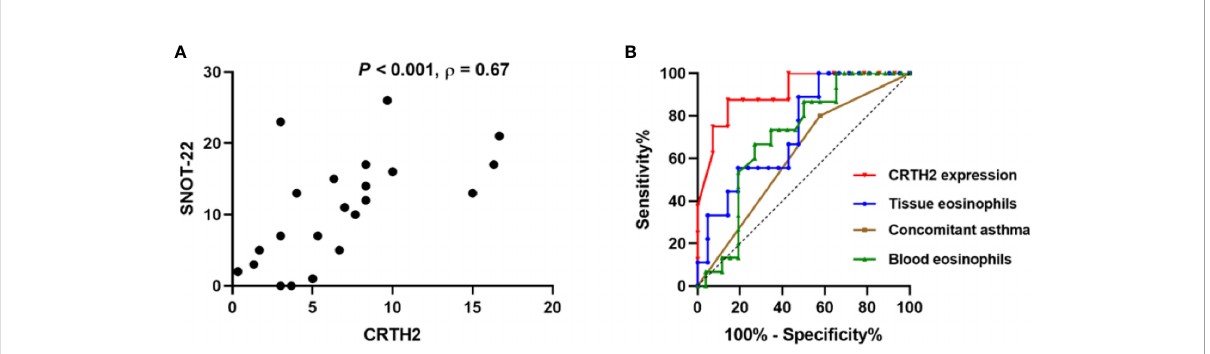
FIGURE 7 (A) Correlation between CRTH2 and SNOT-22 score 12-months postoperatively (n = 22). (B) Receiver operating characteristic curves of tissue CRTH2 expression (red line, AUC=0.9107, P =0.002, 95% CI: 0.7855 to 1.000), tissue eosinophil number (blue, AUC= 0.7354, P =0.044, 95% CI: 0.5497 to 0.9212), concomitant asthma (brown, AUC=0.6115, P =0.239, 95% CI: 0.4348 to 0.7883) and blood eosinophil number (green, AUC=0.7083, P =0.031, 95% CI: 0.5435 to 0.8642), respectively. AUC, area under the receiver operating characteristic